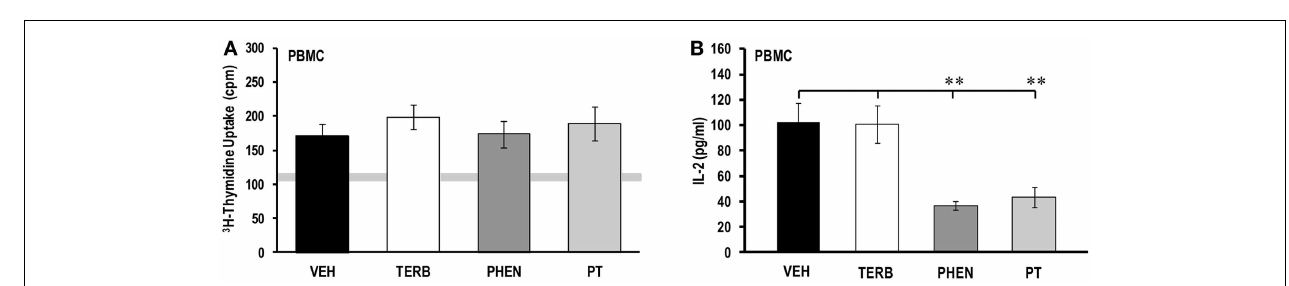
responses 72h post-PBMC cell culture did not differ between treatment groups. N = 8. Gray horizontal bar represents the range for 3 H-thymidine incorporation in unstimulated PBMCs. (B) IL-2 production 24h-post PBMC culture were reduced in PHEN- and PT-treated compared withVEH-treated AA rats. N = 8. All data represent means ± SEM. ** p <